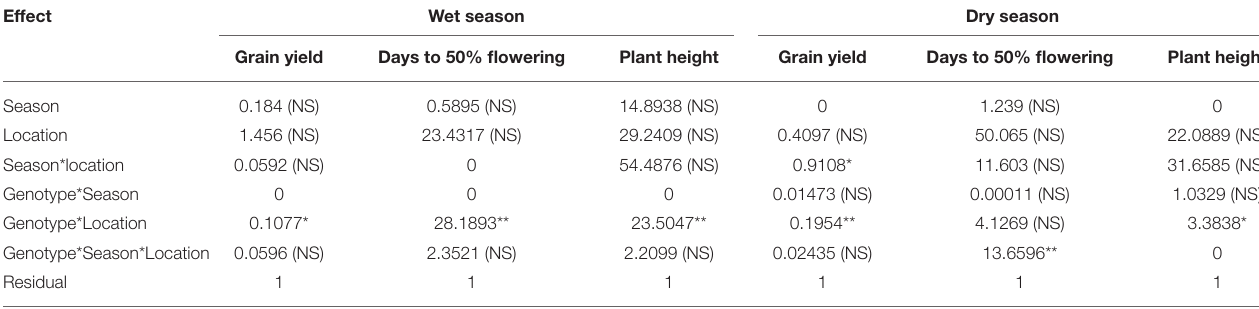
TABLE 4 | REML parameters of the two-stage analysis across the locations and years for each